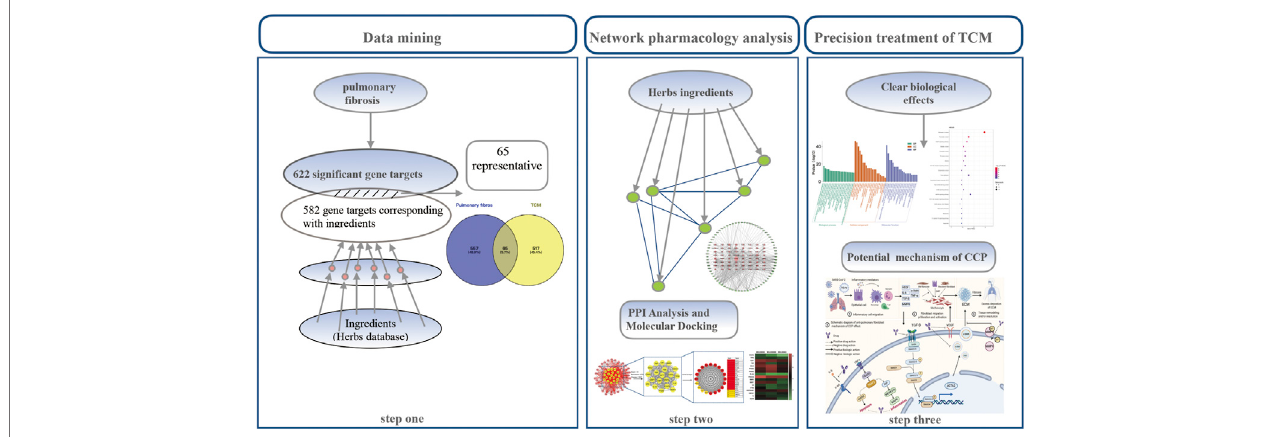
FIGURE 1 | Schematic diagram of the integrated pharmacology strategy approach that combines quantitative analysis of components, network analysis, and molecular docking to investigate the mechanisms of Convalescent Chinese prescription (CCP) treatment against pulmonary fi brosis.